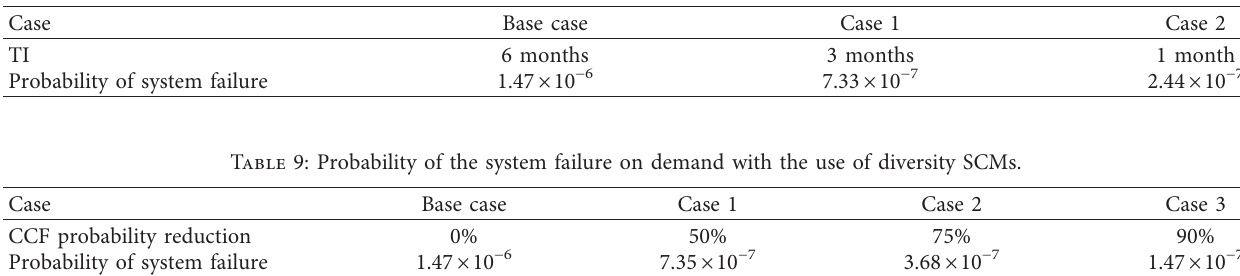
Table 8: Probability of the system failure on demand under different TI.